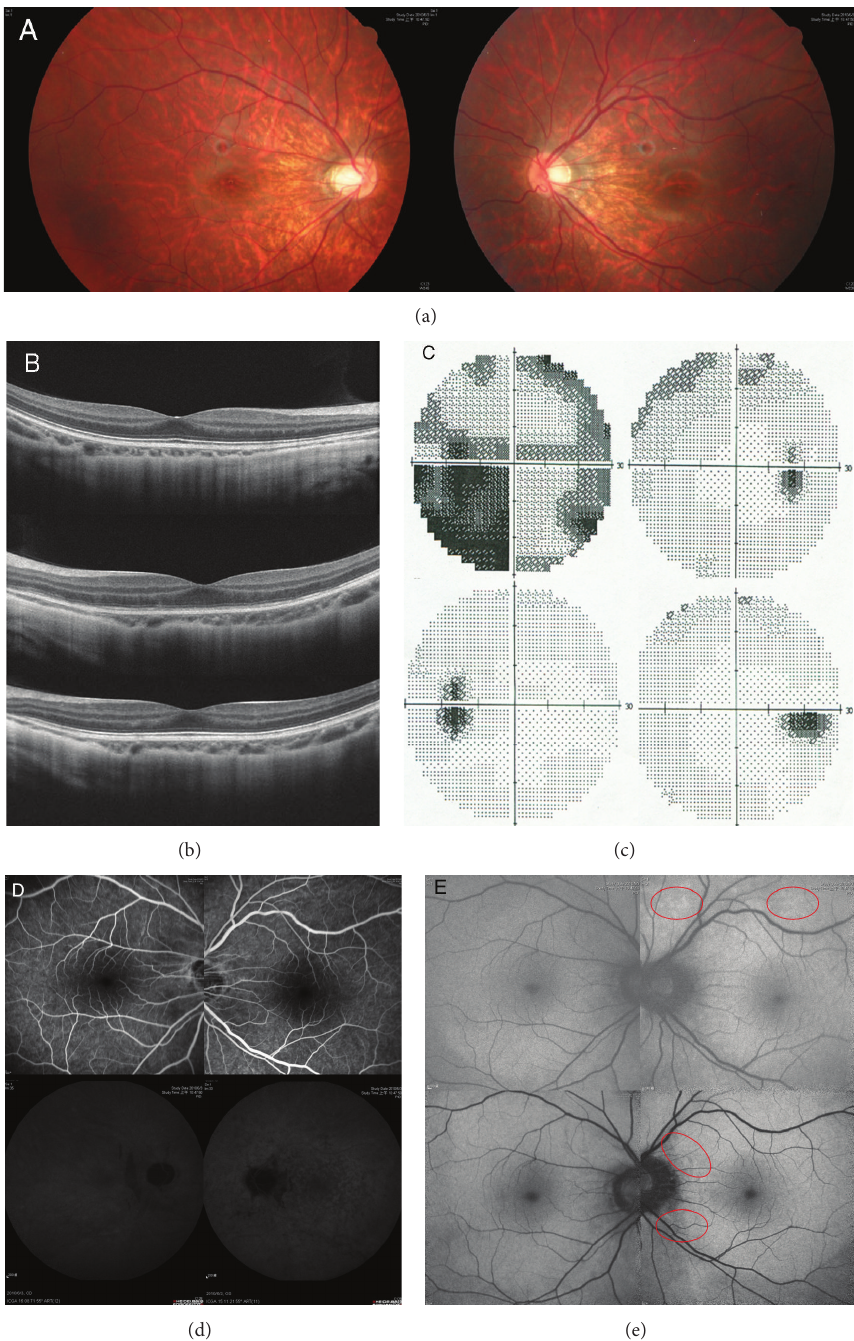
Figure 1: Color fundus in case 3 showed a tessellated myopic fundus with temporal conus in both eyes (a). Optical coherence tomography showed a normal picture in the right eye (b, upper) and a disrupted ellipsoid zone in the left eye at the acute onset stage (b, middle). Recovery of the ellipsoid zone in the left eye was noted 12 months later (b, lower). Humphrey 30-2 visual field showed generalized depressed light sensitivity and visual field defect at the central, temporal lower, and circumferential periphery in the left eye (c, upper). Mild obliteration at the nasal and upper periphery was also noted in the right eye (c, upper). Visual field test 1 year later showed an almost completely recovered visual field in the left eye (c, lower). Fluorescein angiography at the acute stage did not reveal any abnormalities (d, upper). Indocyanine green angiograph shows multiple hypofluorescent, coalescent spots at the posterior pole and peripapillary area in the left eye (d, lower). Fundus autofluorescence (FAF) at acute phase showed some hyperautofluorescent spots at upper aspect of disc and upper vascular arcade in the left eye (e, upper, red circle). FAF imaging 1 year later showed some peripapillary mottled hypoautofluorescence (e, lower, red